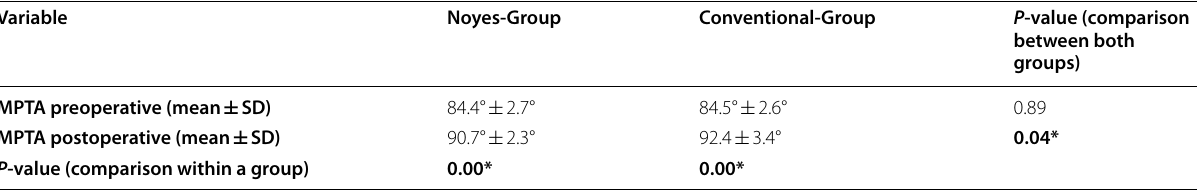
Preoperative and postoperative mean values of the medial proximal tibial angle (MPTA) for the Noyes- and Conventional-Group respectively. P -values are displayed for comparison of the mean MPTA from the pre- to postoperative visit within a group (last row) as well as for comparison of the MPTA between groups (last column). Statistically significant values are marked by asterisks